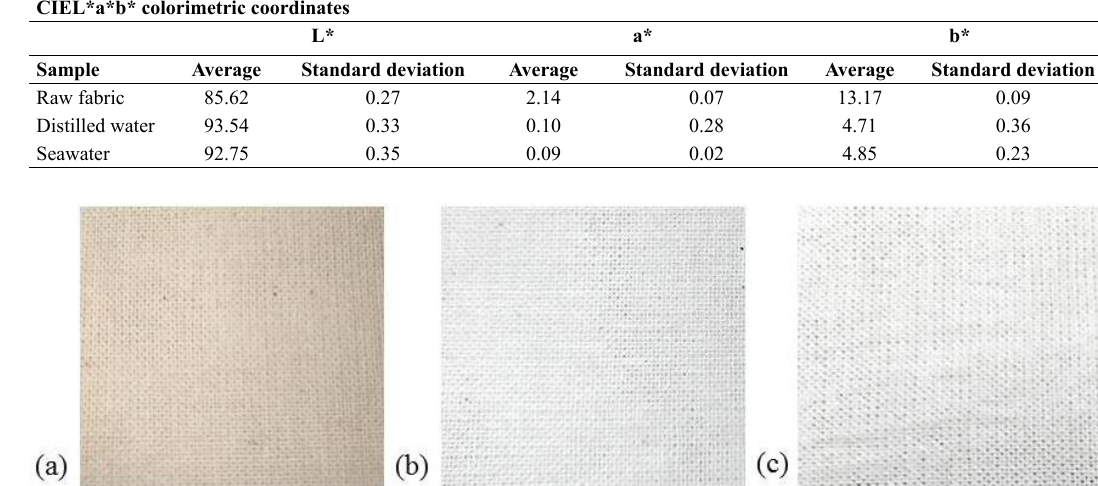
Table 3 . CIEL*a*b* colorimetric coordinates of raw fabric samples and after bleaching process.